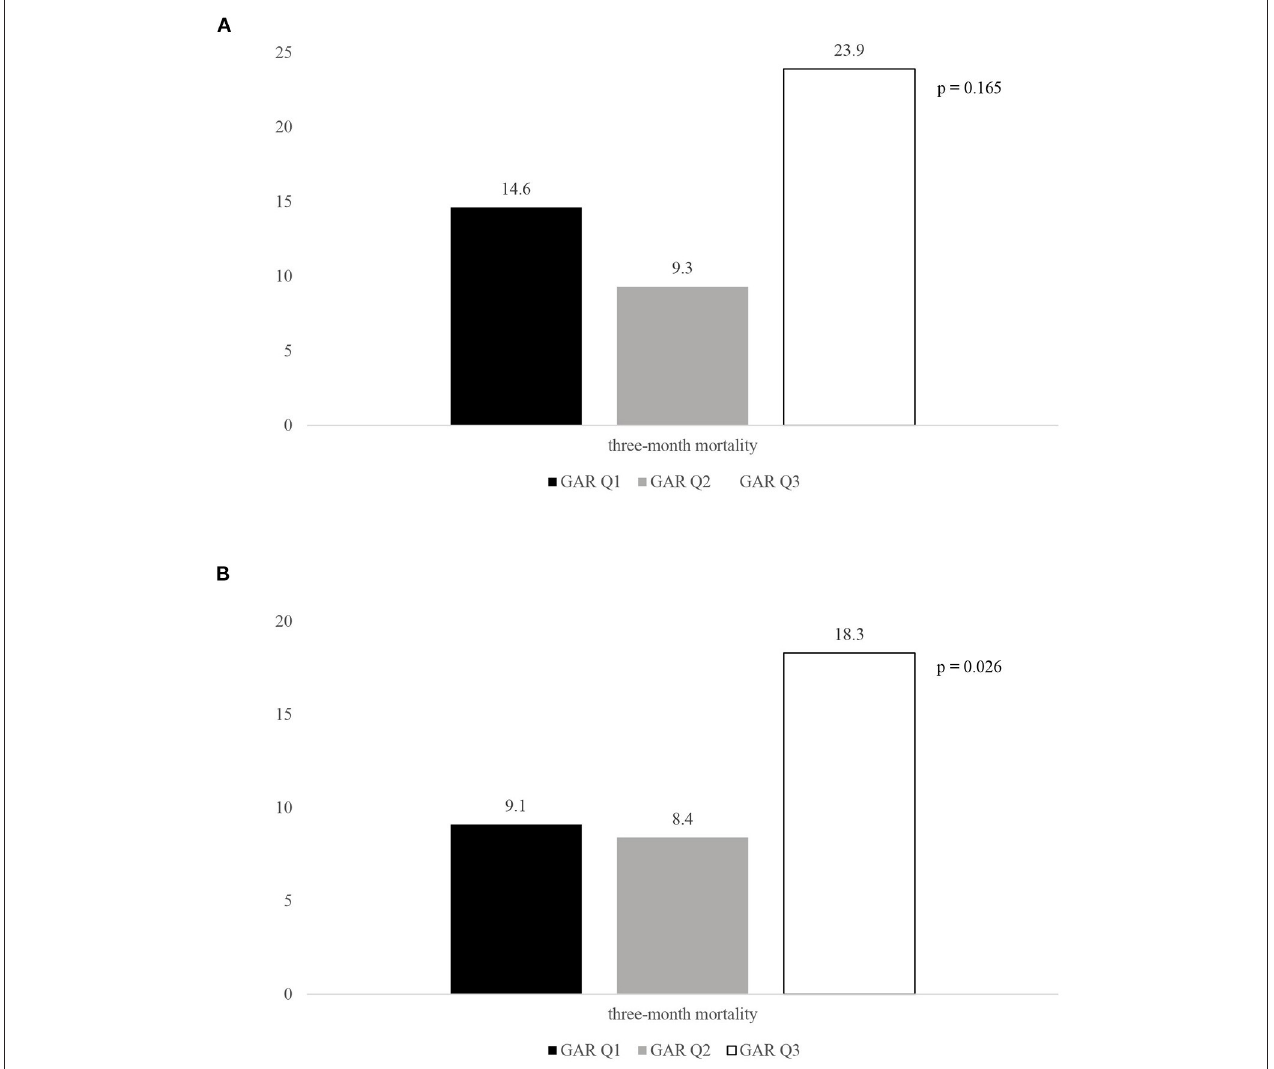
FIGURE 3 | Rates of three-month mortality according to the GAR tertiles in diabetic. (A) and non-diabetic patients (B) . GAR Q1, first glucose-to-glycated hemoglobin ratio tertile; GAR Q2, second glucose-to-glycated hemoglobin ratio tertile; GAR Q3, third glucose-to-glycated hemoglobin ratio